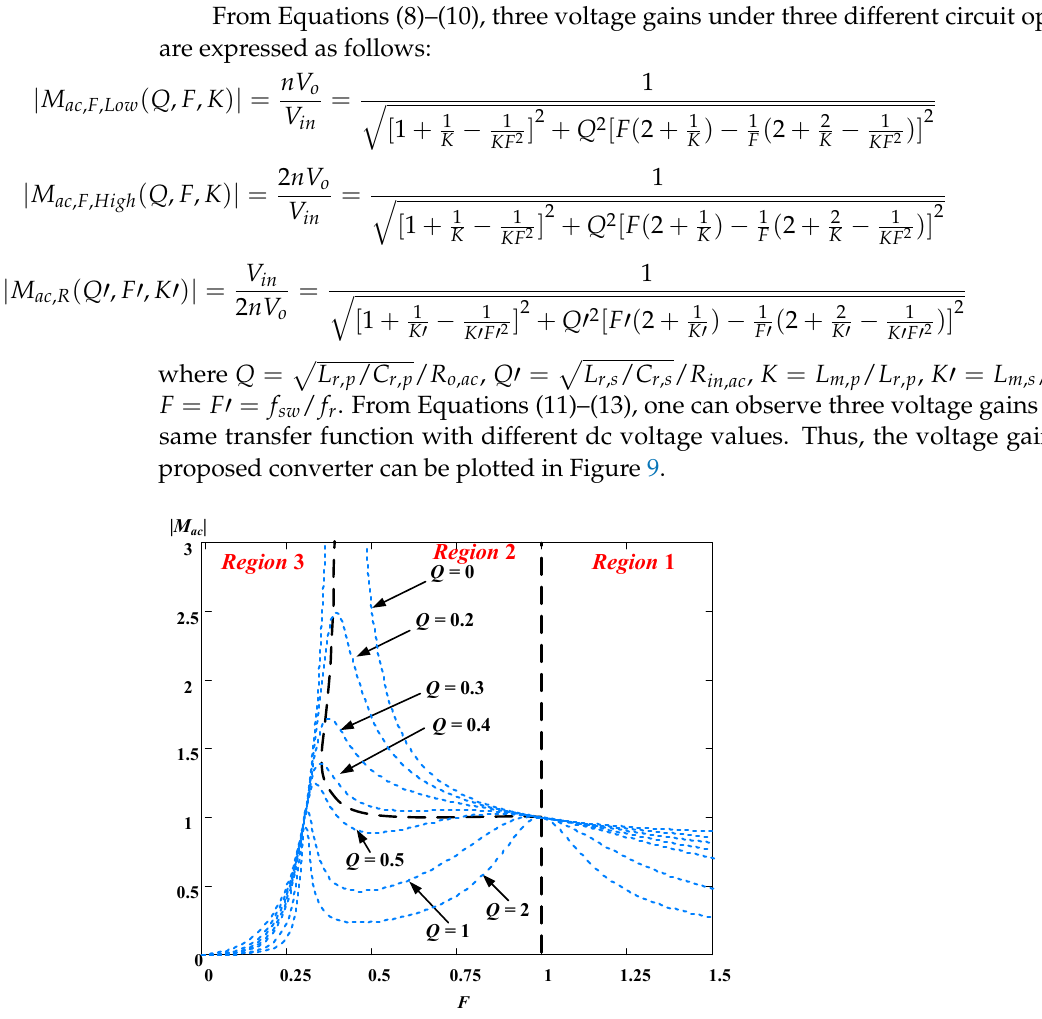
Figure 9. Voltage gains of the proposed